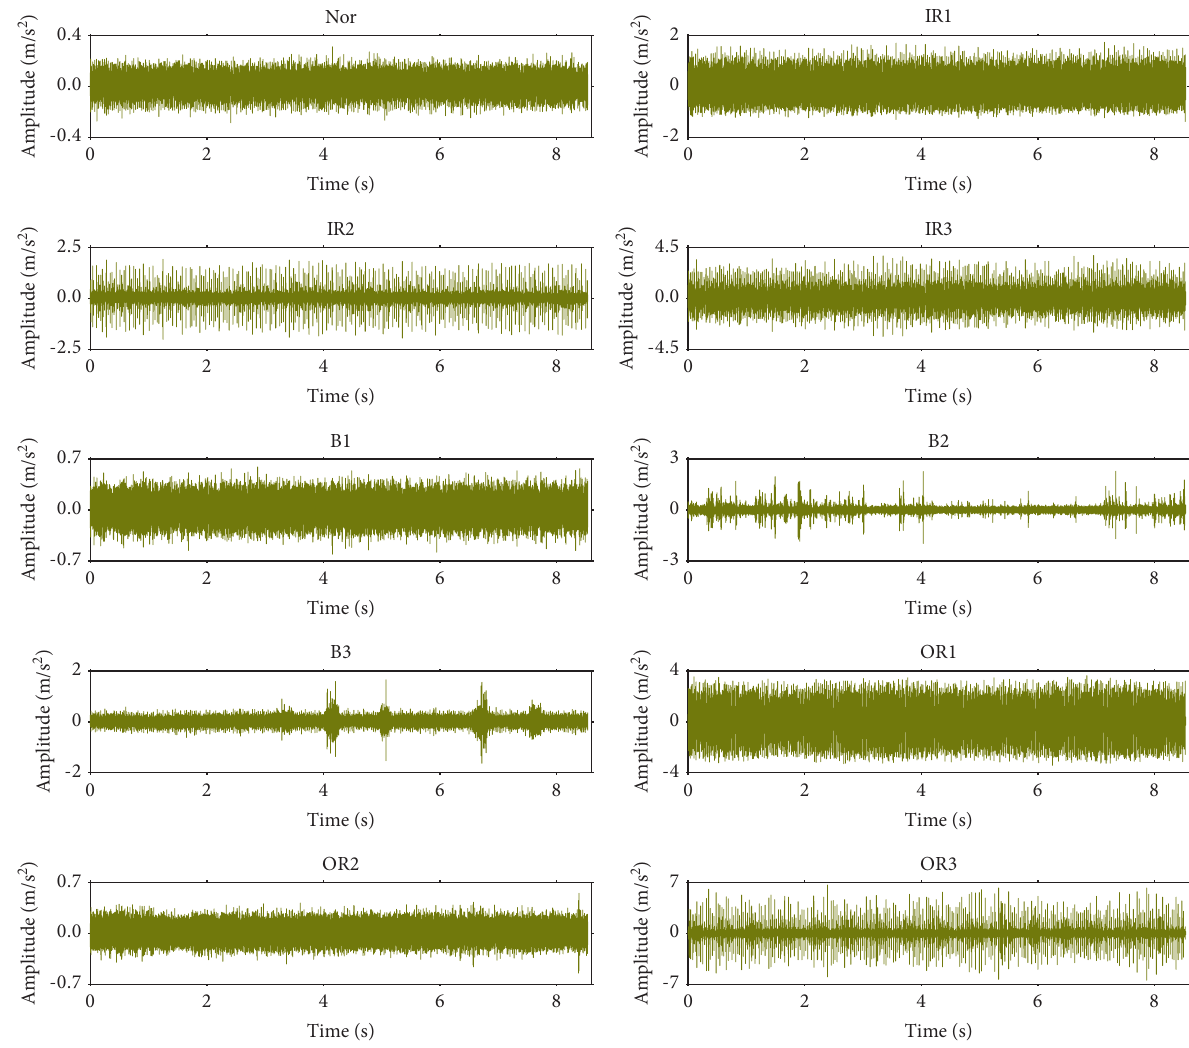
Figure 6: Time-domain waveforms corresponding to different